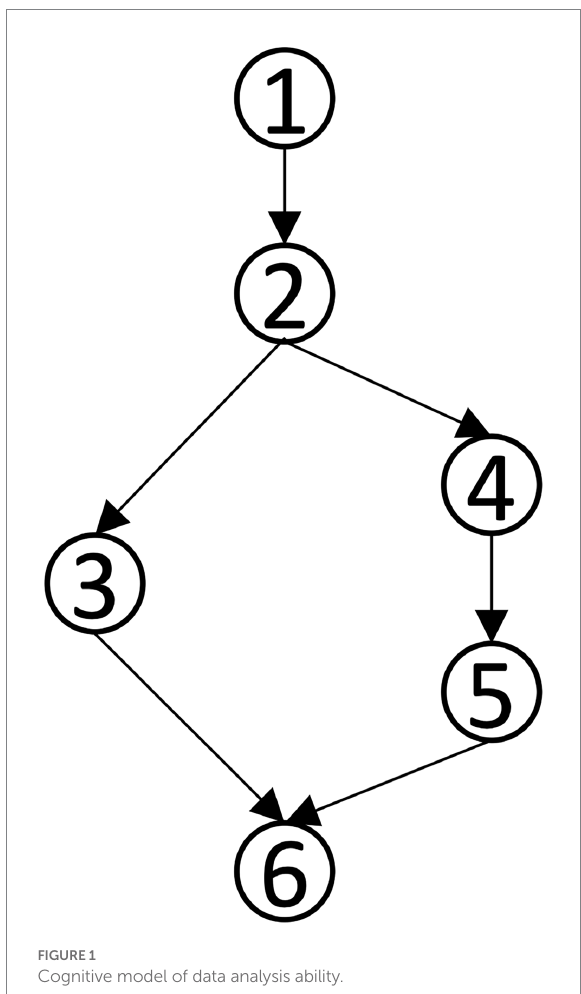
FIGURE 1 Cognitive model of data analysis ability.